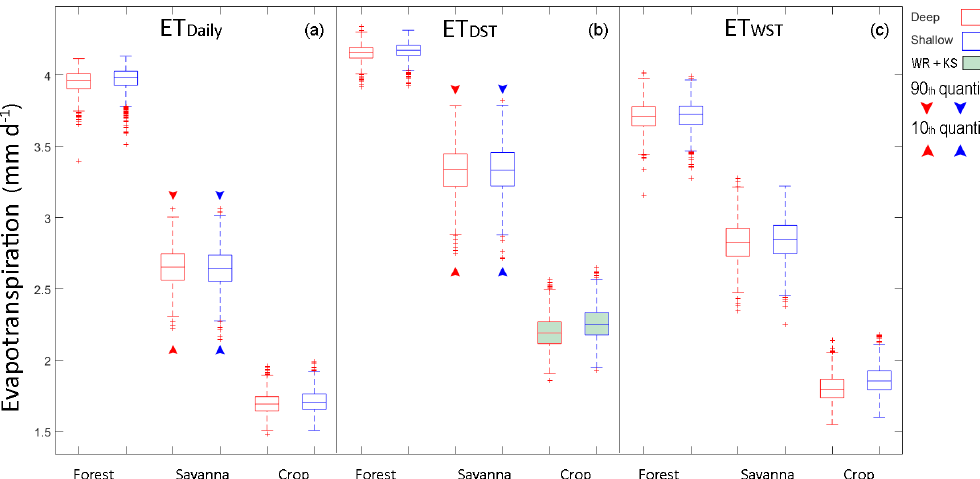
Figure 4. (a) Average daily evapotranspiration (ET) annually ET daily , (b) during the dry season transition period ET DST , and (c) during the wet season transition ET WST . Red boxes represent deep WTD. Blue boxes represent shallow WTD. Significant results are shown by the green filled boxes if significance was found with both Wilcoxon rank (WR) and Kolmogorov–Smirnov (KS). Significant differences in the 10th and 90th quantiles are depicted by the arrows.